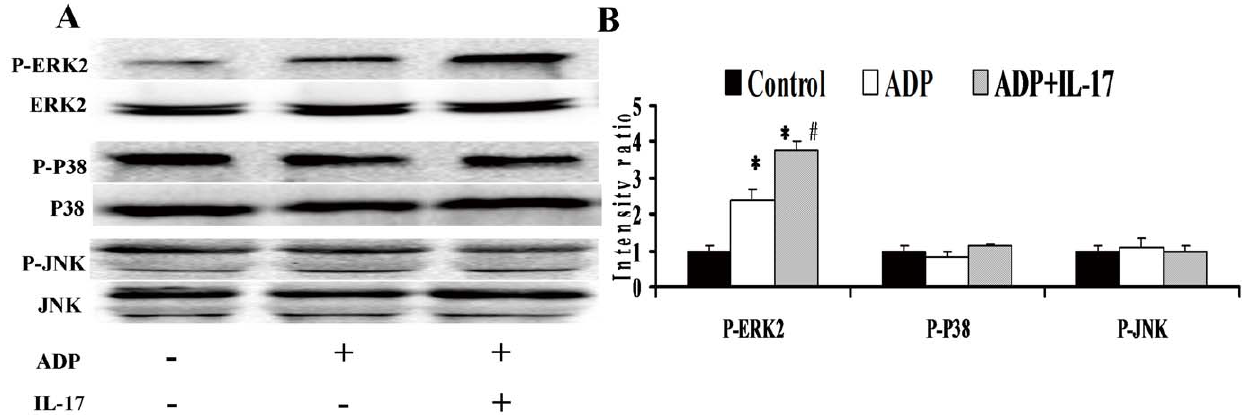
Figure 4. The function of IL-17A on MAPKs in the platelet. (A) Representative pictures for the MAPKs phosphorylation in different intervention. (B) The results of statistical analysis for the intensity ratio of MAPKs phosphorylation in different intervention. *, p , 0.05 vs Control and ADP group; # , p , 0.05 vs ADP group. Values are means 6 SEM of five independent experiments with different donor platelets.